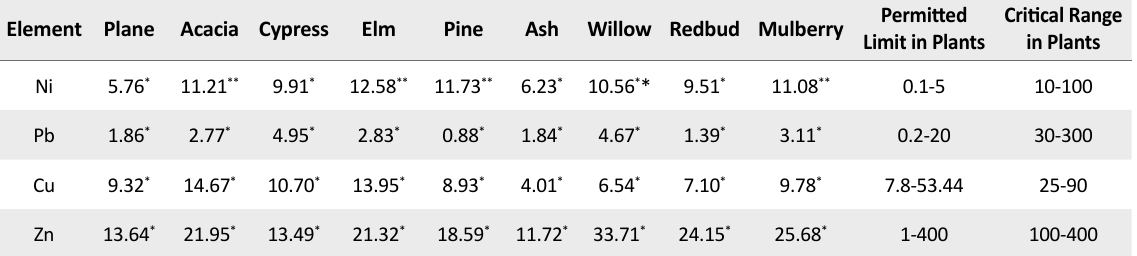
Table 9. Comparison of heavy metal concentrations in different species in the present study with the standard range reported by Kabata-Pendias and Pendias (Kabata-Pendias-Pendias) for plants (mg/kg)